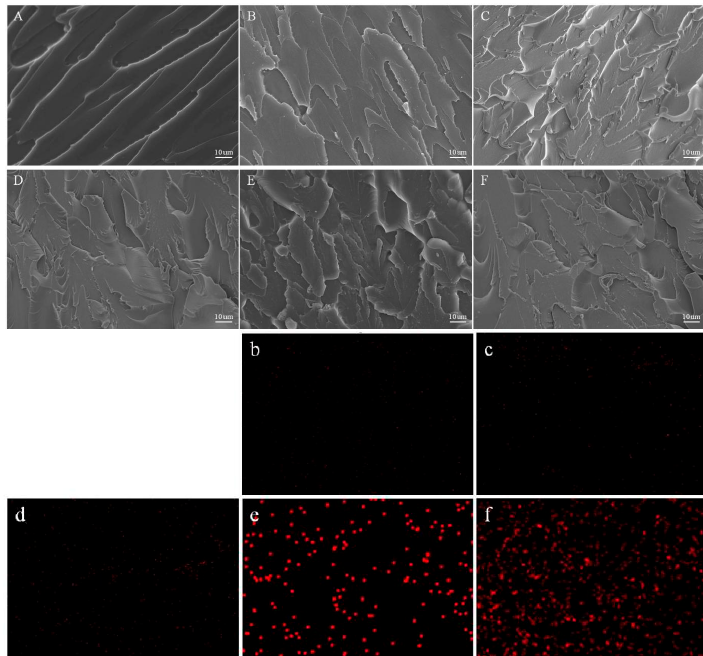
Figure 5. SEM images of the fractured surfaces of PMMA resin containing CNCs-Ag with different mass concentrations after flexural testing: ( A ) 0%; ( B ) 0.05%; ( C ) 0.1%; ( D ) 0.15%; ( E ) 0.2% and ( F ) 0.25%. Panels ( b – f ) are the element mapping images of silver element in the resins.